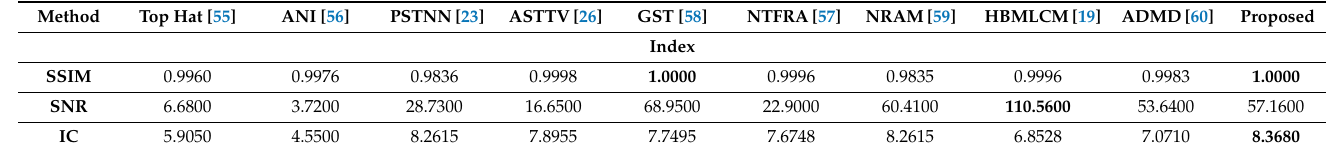
Table 10. Calculation of indicators in scenario F of each model.